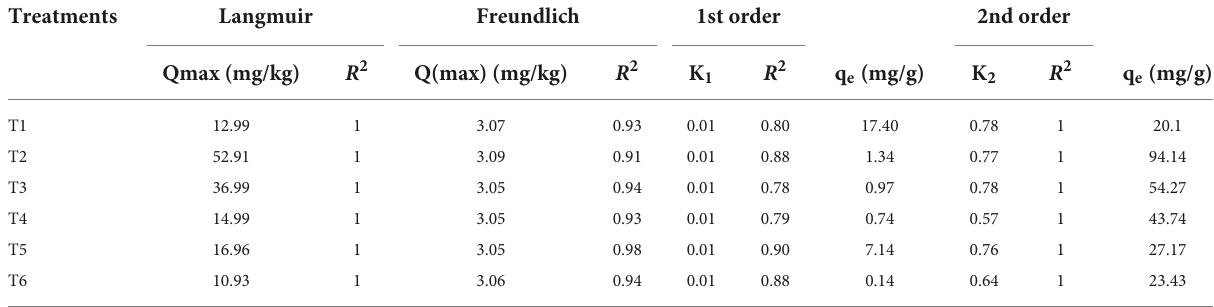
TABLE 3 Comparison of Langmuir and Freundlich isotherm models for different concentrations of adsorbents and pseudo 1st and 2nd order in terms of their R 2 -values for the treatments (T1 = 1% bentonite, T2 = 2% bentonite, T3 = 3% bentonite, T4 = 4% bentonite, T5 = 5% bentonite, T6 = 6%